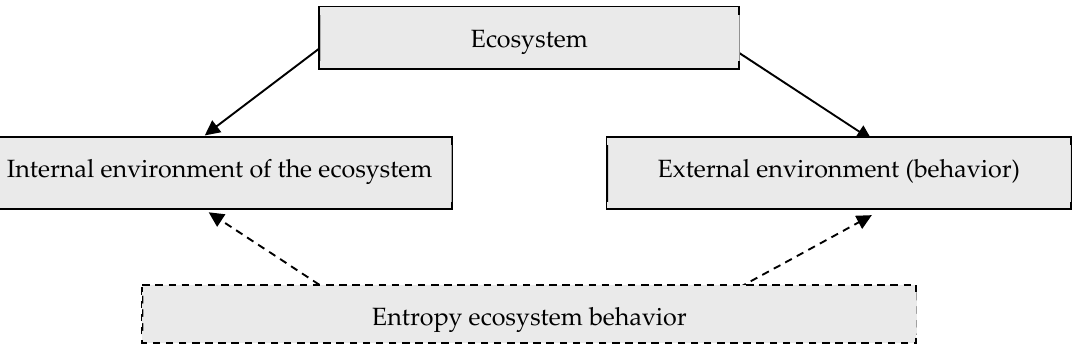
Figure 1. Interpretation of an ecosystem entropy behavior.